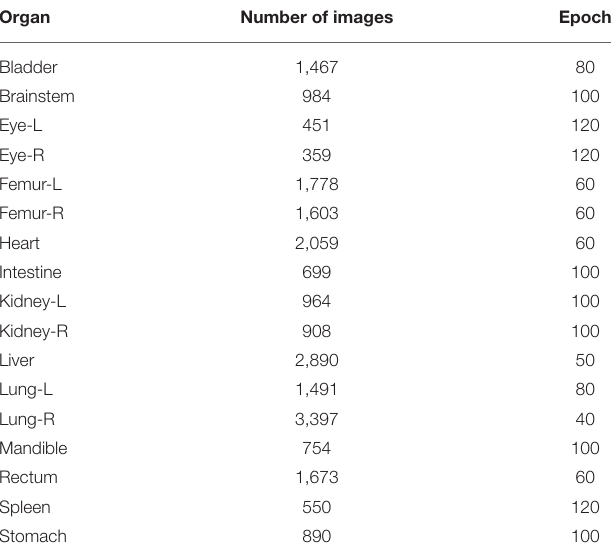
TABLE 3 | The training epoch and CT image numbers for the different